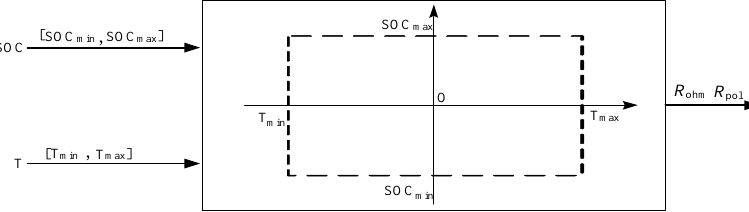
Figure 4. Internal resistance DOE (design of experimental) model based on CCD (central composite design).